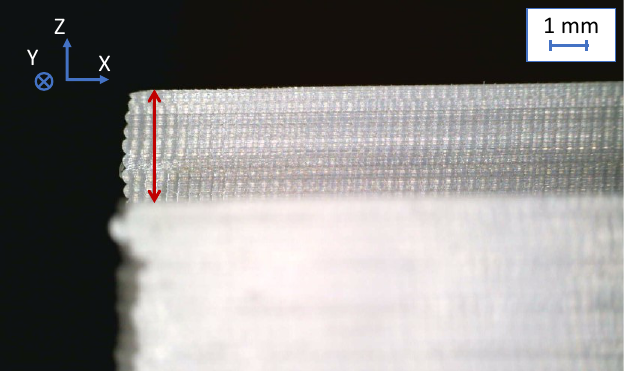
Figure 12. Surface topography of the qualification point for the tool dedicated to composites, v c = 324 m/min, f z = 0.030 mm/tooth, a p = 3 mm, and a e = 0.5 mm. No material pull-out was observed. The working point of the universal tool was evaluated as exhibited in Figure